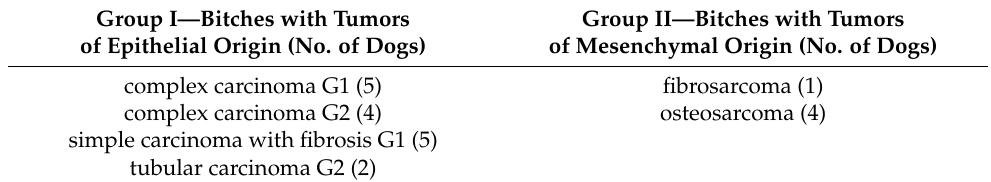
Table 1. Tumor types of female dogs with malignant mammary tumors in the experimental groups. Group I—Bitches with